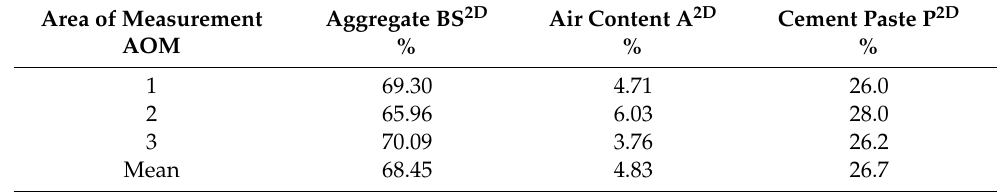
Table 3. Microscopic measurement